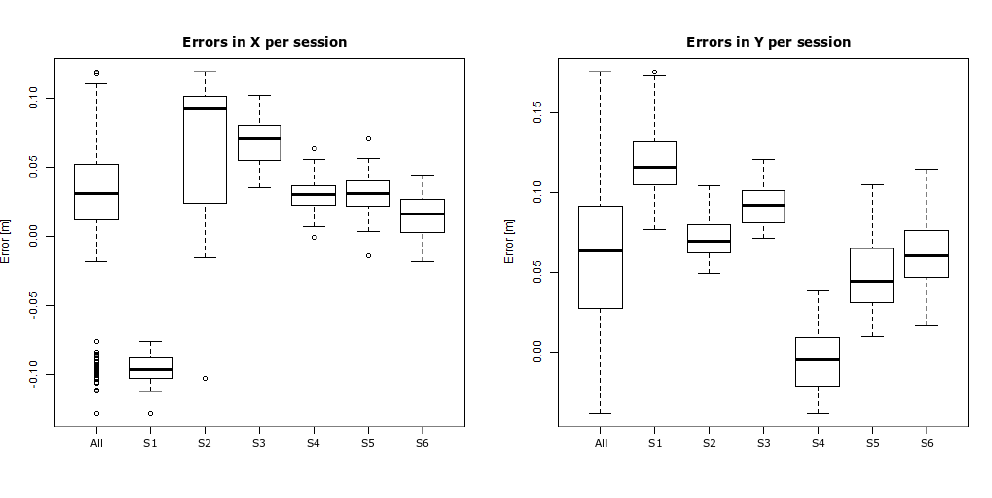
Figure 13. Plot of all 13 target positions. Ground truth positions are plotted in green and averages of the 23 measured positions in red.